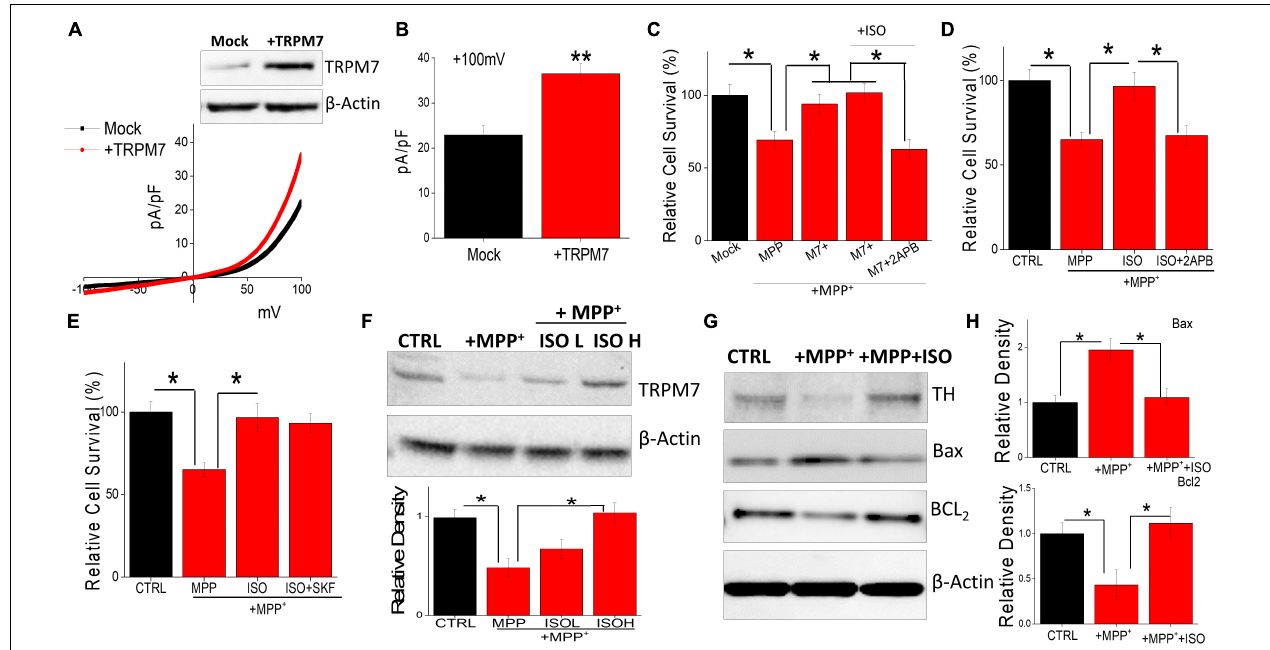
FIGURE 3 | Restoration of TRPM7 expression inhibits neurotoxin-induced loss of SH-SY5Y cells: IV curves in control and TRPM7 overexpressing cells were measured and shown in (A) . Western blots were also performed in these cells to look at TRPM7 expression under these conditions. Quantitation of current density at +100 mV is demonstrated in (B) . (C–E) MTT assays were performed to observe cell survival on TRPM7 overexpressed cells (C) and control cells (D,E) with and without MPP + (500 µ M for 24 h) under various conditions as labeled (+ISO 20 µ M, or +SKF 10 µ M). The columns show the means ± SD of 5 individual experiments performed in triplicates. (* p < 0.05; One-way ANOVA, Tukey post hoc test). Sample from differentiated SH-SY5Y [treated for 24 h with MPP + 500 µ M, with and without ISO 20 µ M (L) and 40 µ M (H)] were resolved and protein expression was evaluated by western blotting, antibodies use is labeled in the figures (F) . Quantification of TRPM7 is shown as bar graph. (G) Also shows western blots under different conditions, antibodies used are labeled in the figure. (H) Shows quantification where the columns represent mean ± SD of 3 independent experiments that were normalized by β -actin expression. (* p < 0.05; ** p < 0.01; One way ANOVA, Tukey post hoc